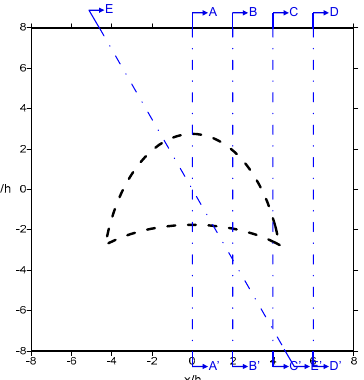
Figure 6. Positions of cross-sections A–A ′ , B–B ′ , C–C ′ , D–D ′ , and E–E ′ .